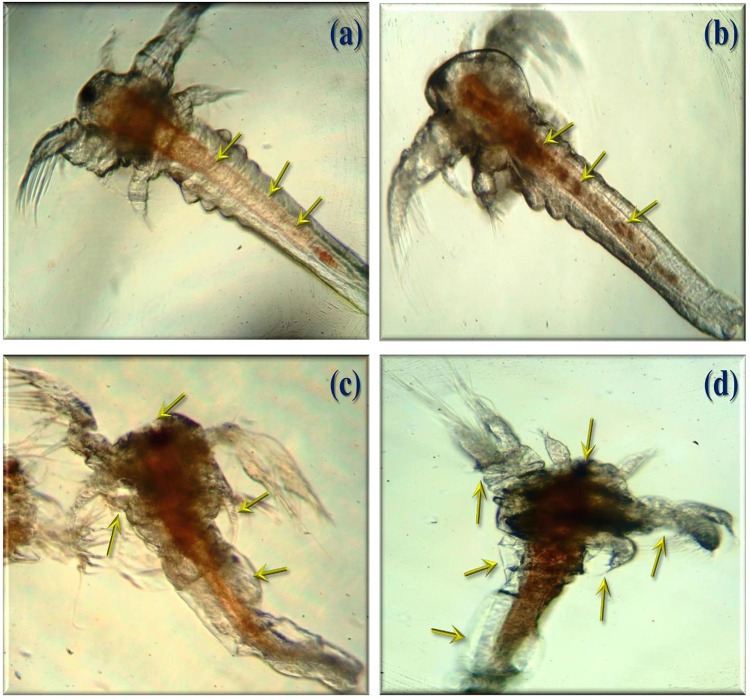
Ingestion of A. terreus mycelium ethyl acetate extracts to Artemia nauplii larvae (100 μg/ml) (a). The empty guts in the control group of larvae (b). Yellow arrow indicates the A. nauplii ingested with extract in the exposed larvae. (c) Morphological changes A. nauplii (eyeball shape, loss of eye color, and intestinal enlargement). (d) Loss of antennae and deformation of antennae.